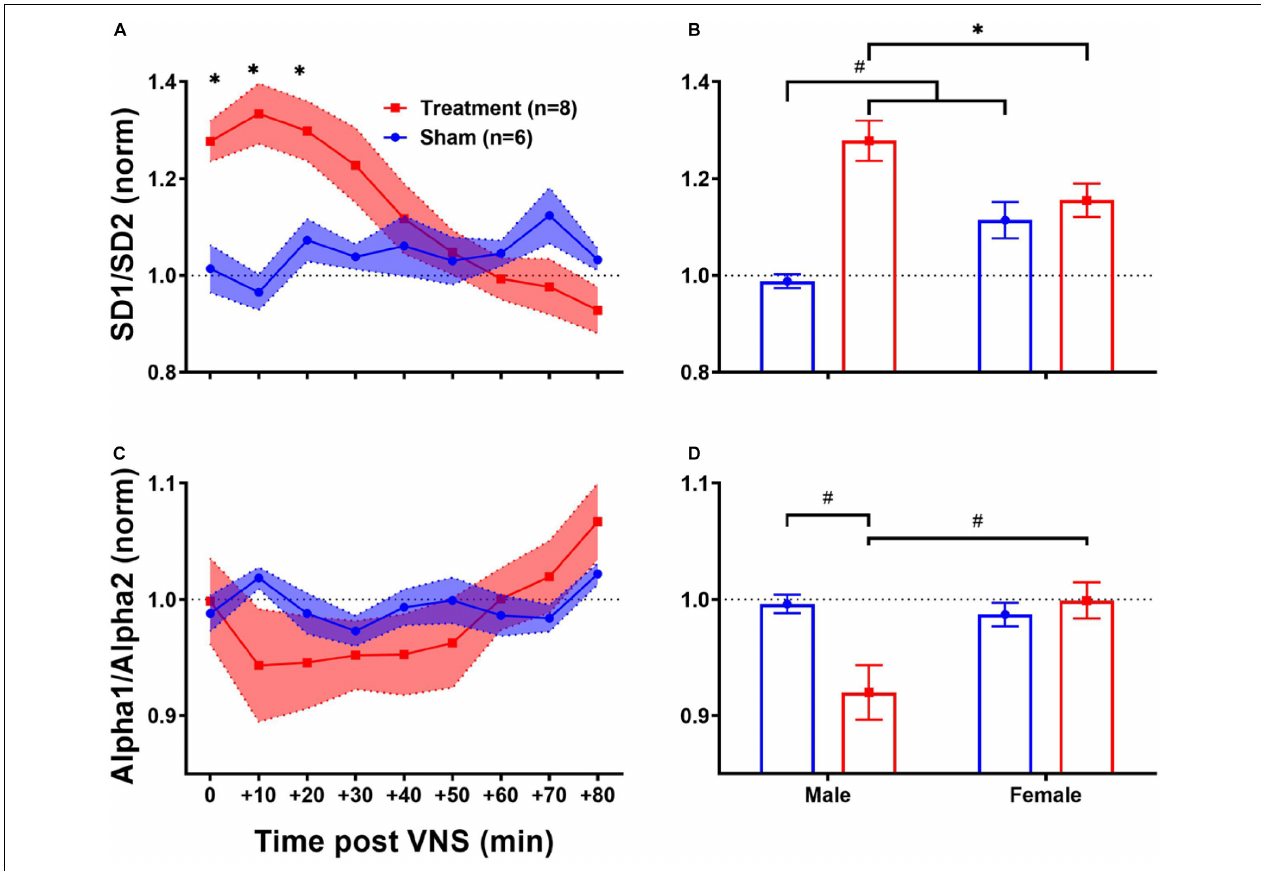
FIGURE 7 | Normalized short-term trends for HRV non-linear features (mean ± SEM). (A,B) SD1/SD2 significantly increases by VNS and then recovers after about 30–40 min. Male–female comparison revealed that the effect was only significant in male rats. (C,D) Alpha1/Alpha2 slightly decreases by VNS without significant difference compared to the Sham group. Male–female comparison shows that the effect is only significant in male rats. * p < 0.05 and # p <